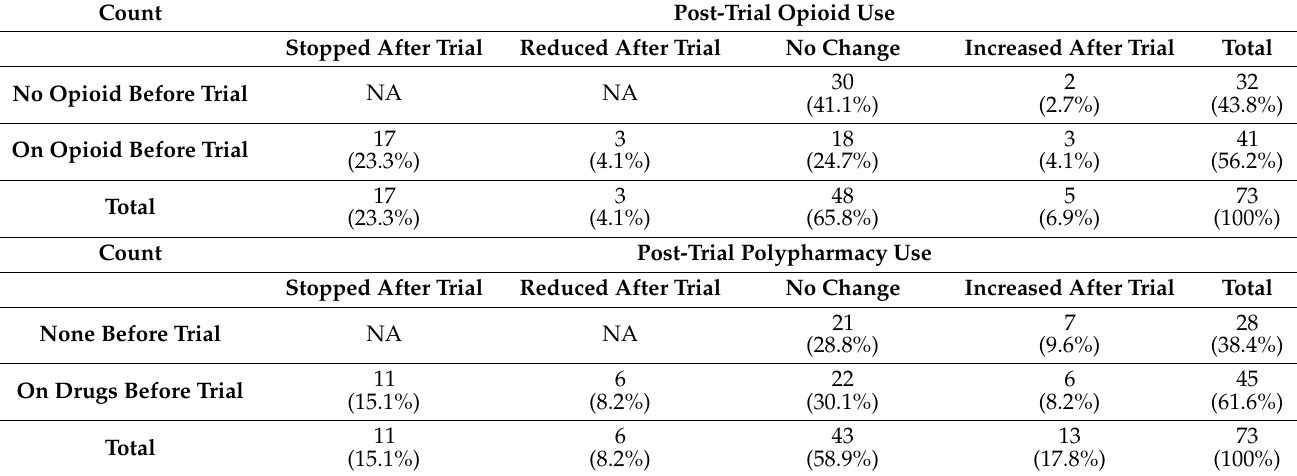
Table 6. Bivariate analysis of medication-related